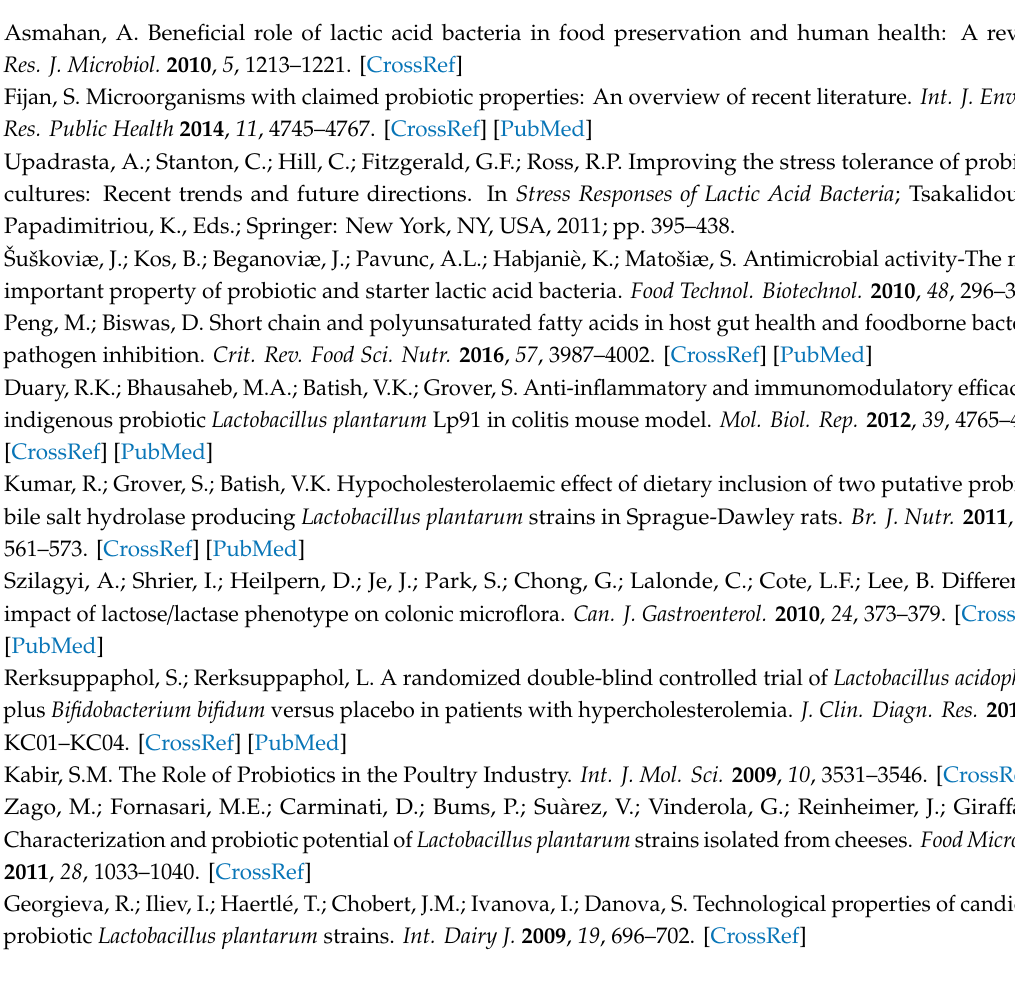
Figure S1: PCR confirmation of LP + PR strain. 1% Agarose gel electrophoresis analysis of total DNA extracted from bacteriophage J1 (lane 1), LP + PR strains (lanes 2–4), and wild-type LP strain (lane 5). M, 1 kb marker